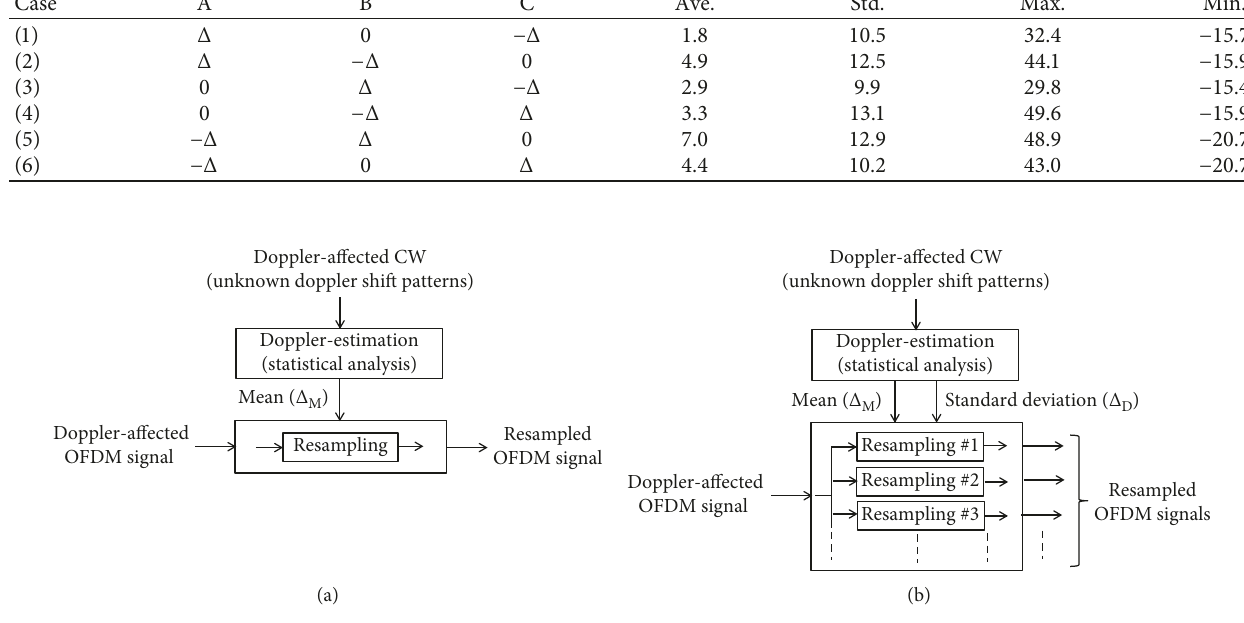
Figure 9: Conceptions of single and parallel resampling techniques. (a) Single resampling and (b) parallel